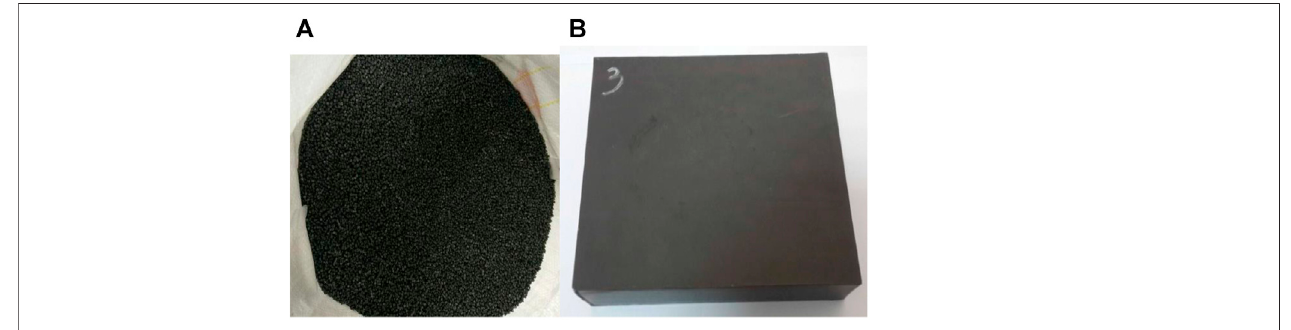
FIGURE 1 | Samples of the lead – boron polyethylene shielding composite.